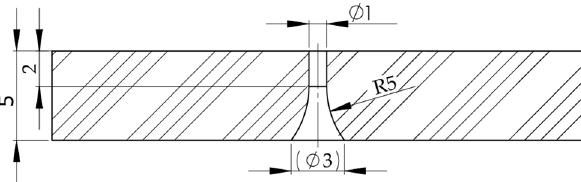
Figure 3. Cross-sectional dimensions of the entrance and exit die of the thermoplastic pultrusion